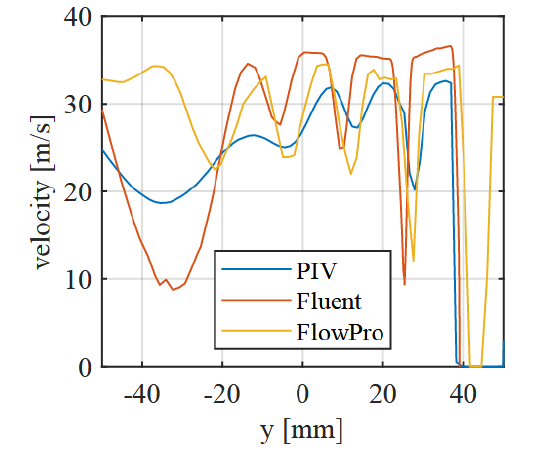
Fig. 3a. Velocity profile comparison 100 mm behind for -8°.